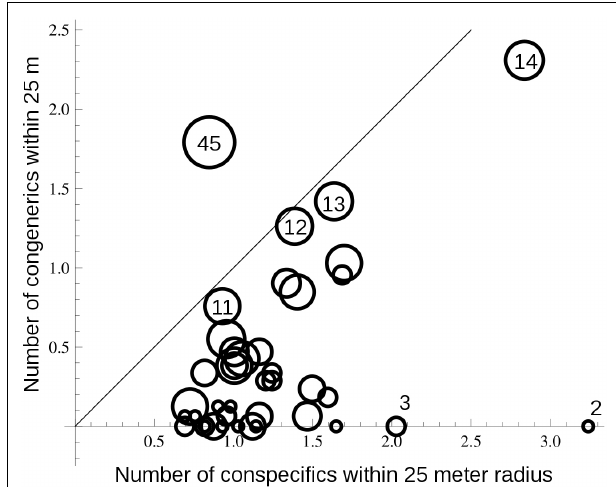
FIGURE 4 | The relationship between the number of conspecific and congeneric individuals in a local neighborhood with 25 m radius around focal trees. Focal trees represent species with different numbers of sympatric congenerics in the Pasoh 50-ha plot. Each circle represents the mean values for 15 individuals from 61 of the most abundant species in each suite of sympatric congeners. The diameter of each circle indicates the number of congeneric species present in the community for each species. Several circles are labeled to indicate scale. The solid line illustrates a 1:1 ratio. Mean neighborhood size was 197 individuals composed of an average of 104